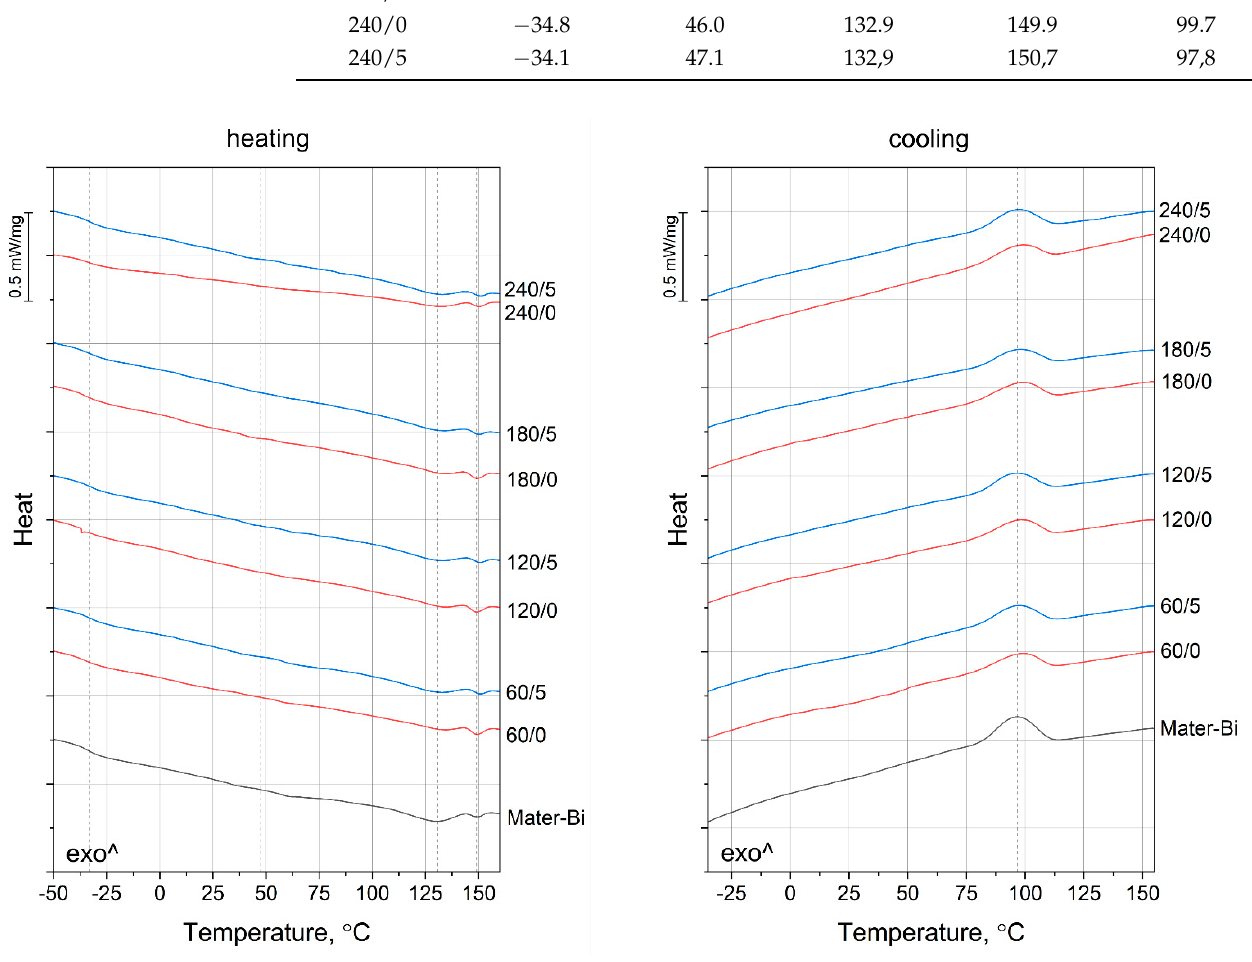
Figure 5. DSC thermograms registered during the second heating and cooling of Mater-Bi and its composites.